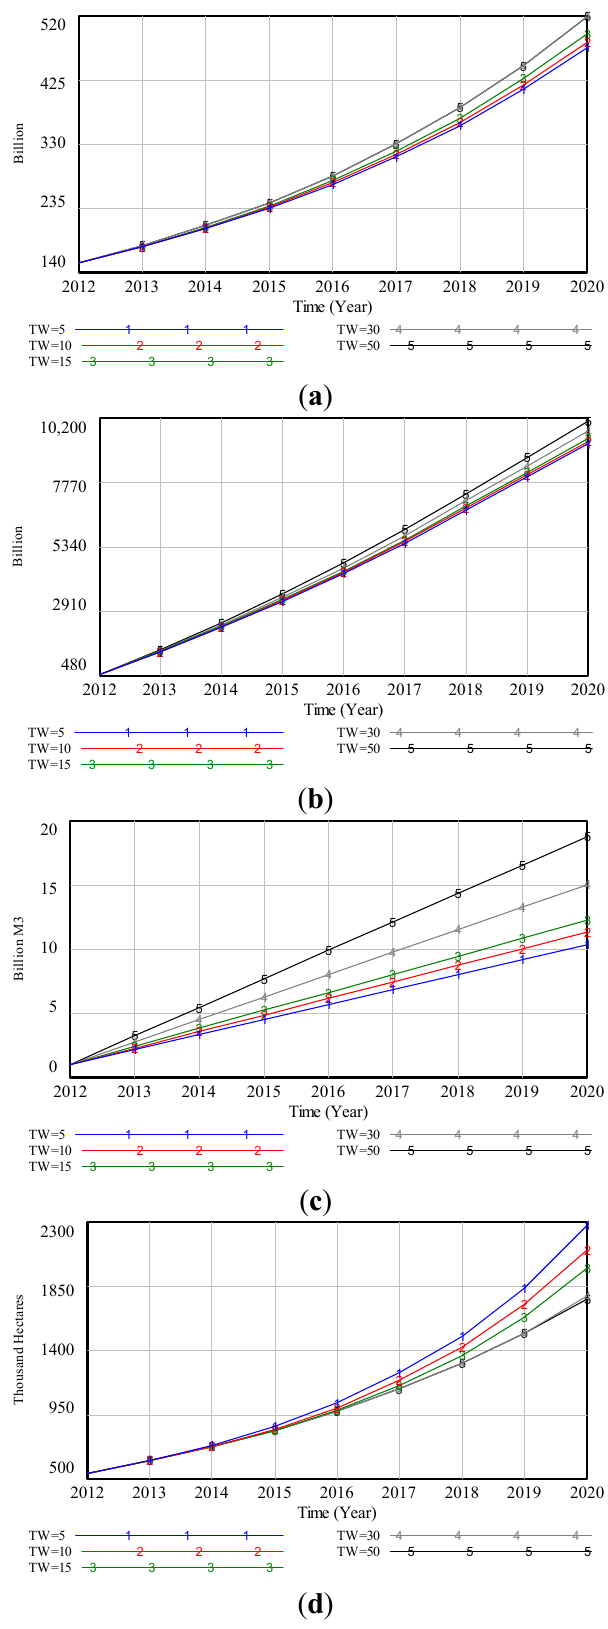
Figure 3. Economic and environmental effects respond to different transferred water (TW) levels. ( a ) Agricultural GDP; ( b ) Industrial GDP; ( c ) Accumulated Wastewater; ( d ) Groundwater Funnel